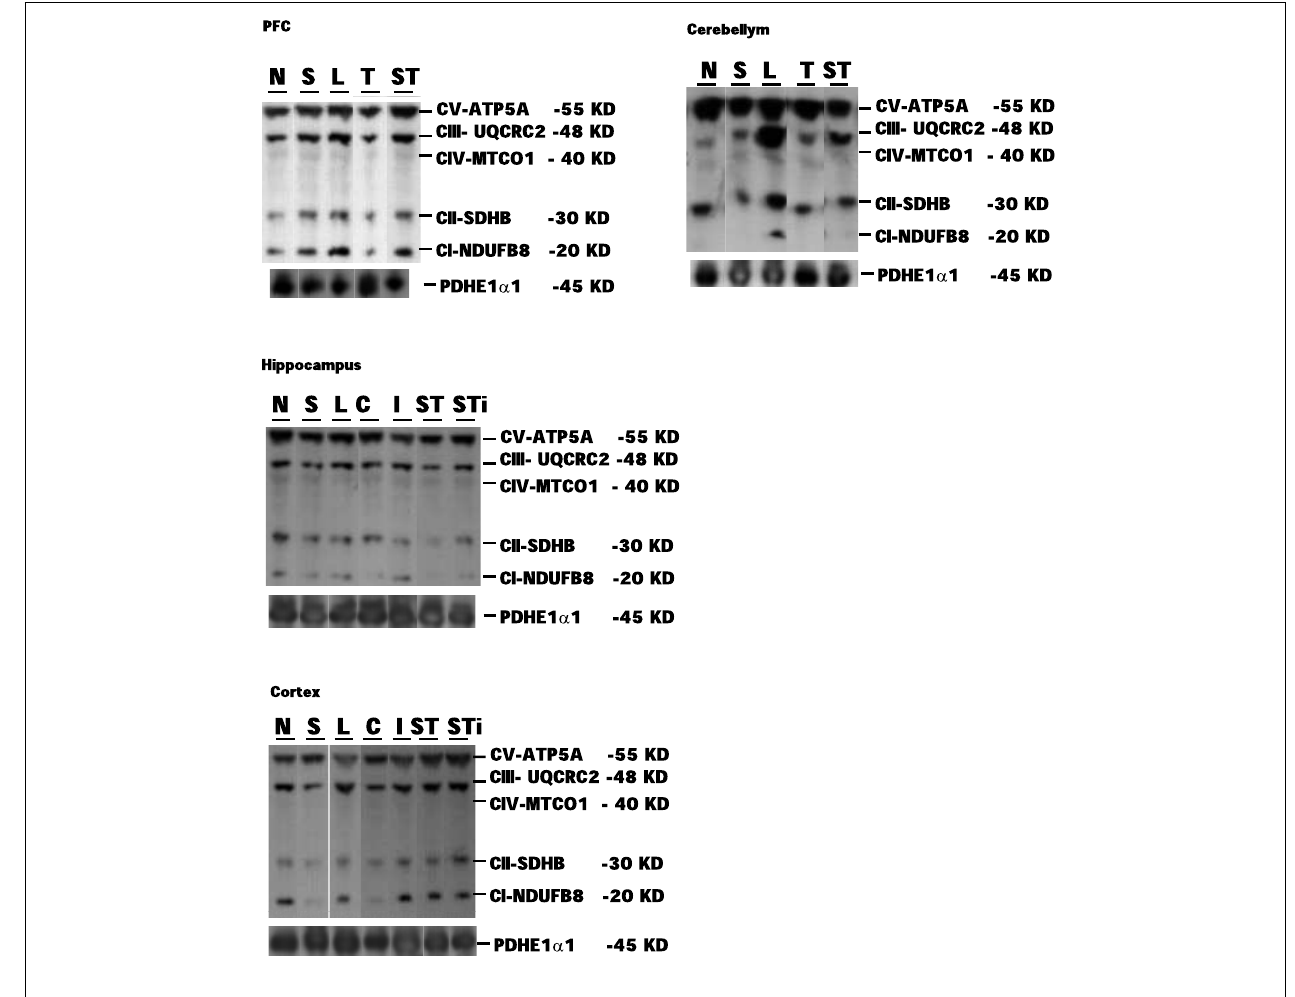
S-mTBI animals.Twenty micrograms of total proteins were resolved on SDS-PAGE gel and incubated with the primary antibodies against each protein. N, Naïves; S, Stress;T, mTBI; ST, stress followed by mTBI; C, contralateral mTBI; I, ipsilateral mTBI; ST, contralateral S-mTBI; STi, ipsilateral